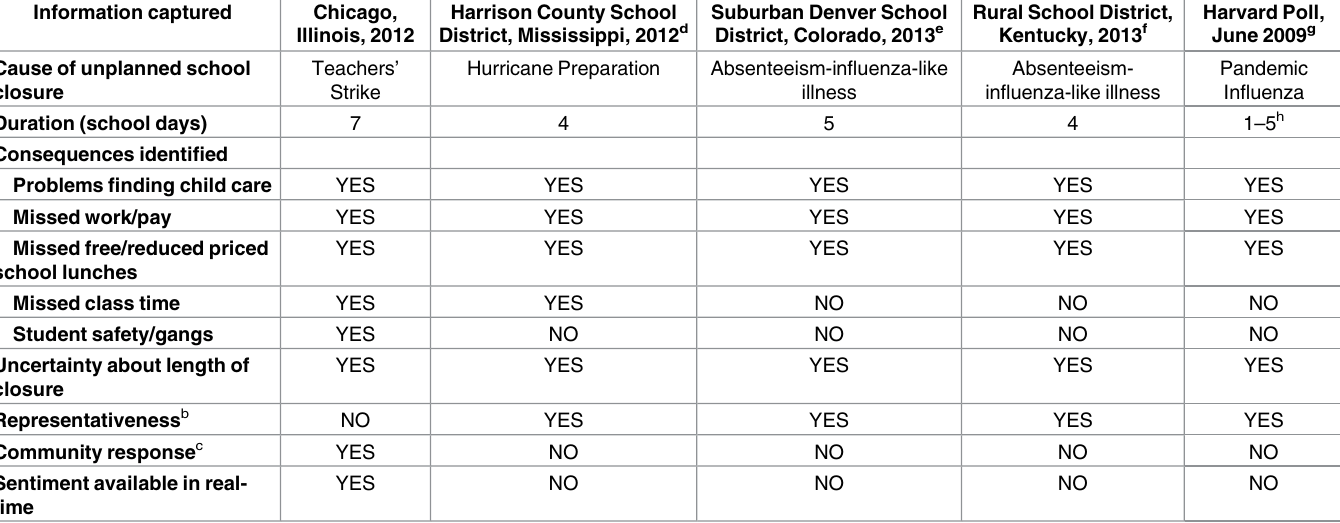
Table 3. Qualitative comparison of the Chicago teacher’s strike social media findings with results from traditional household surveys in Missis- sippi, Colorado, and Kentucky and a telephone poll about the costs and consequences of unplanned school closures a